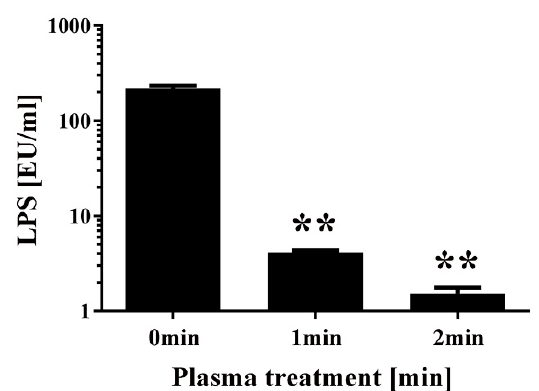
Figure6. CATactivityin E.coli transformedwithanampicillinresistancegene-andCATgene-containing plasmid, selected on ampicillin-containing agar medium, and proliferated in liquid medium with ampicillin ( (cid:4) ) or without ampicillin ( (cid:3) ) was decreased by DBD plasma torch treatment. E. coli transformed with an ampicillin resistance gene- and CAT gene-containing plasmid pPRO-EX-HT-CAT and selected on ampicillin-containing medium were proliferated in ampicillin-containing liquid medium (Amp( + )) ( (cid:4) ) or ampicillin-free liquid medium (Amp( − )) ( (cid:3) ) and then subjected to DBD plasma torch treatment for 0–2 min. The activity of CAT in the bacteria was subsequently measured using an acetyltransferase activity assay kit (Enzo Life Sciences, Inc.) with an excitation wavelength of 400 nm and emission wavelength of 490 nm. Di ff erences where p < 0.01 (**) versus control (0 min) were significant when verified by the non-repeated measured ANOVA followed by the Bonferroni correction.